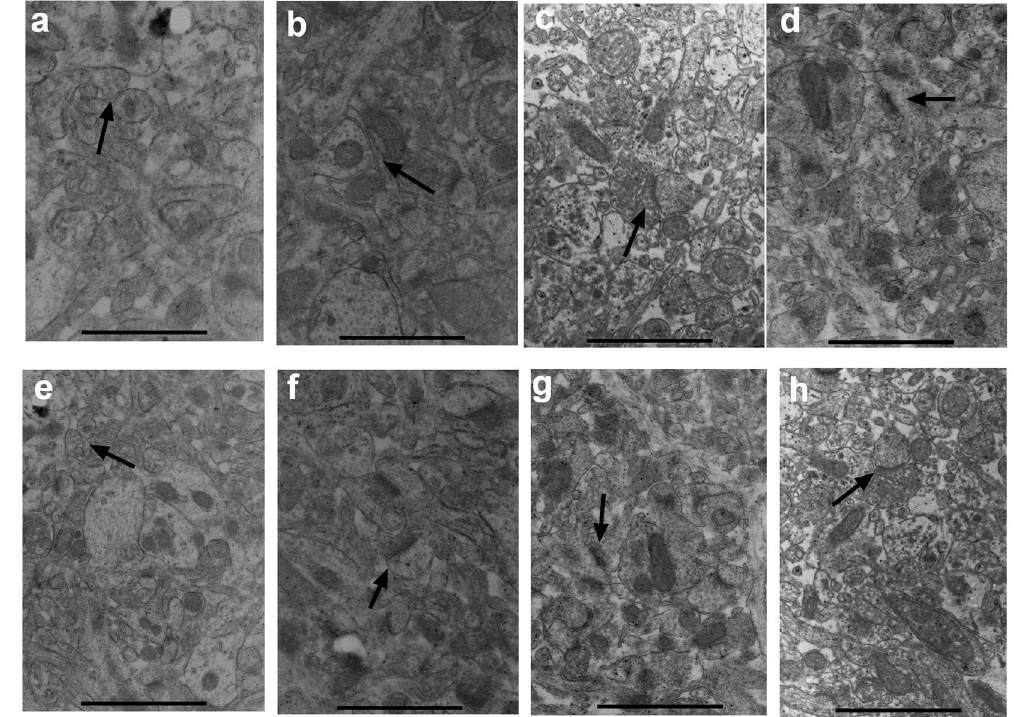
Figure 2. Transmission electron microscopy of synapse ultrastructure and numbers of synaptic vesicles, note the postsynaptic density (arrows). ( a ) synapse of control group, ( b ) 25 μ mol/kg MnCl 2 -treated group, ( c ) 50 μ mol/kg MnCl 2 -treated group, ( d ) 100 μ mol/kg MnCl 2 -treated group, ( e ) calpeptin control group, ( f ) 25 μ g/ kg calpeptin pre-treated group, ( g ) 50 μ g/kg calpeptin pre-treated group, ( h ) 100 μ g/kg calpeptin pre-treated group. Magnification: × 10000; Scale bars represent 500 nm.